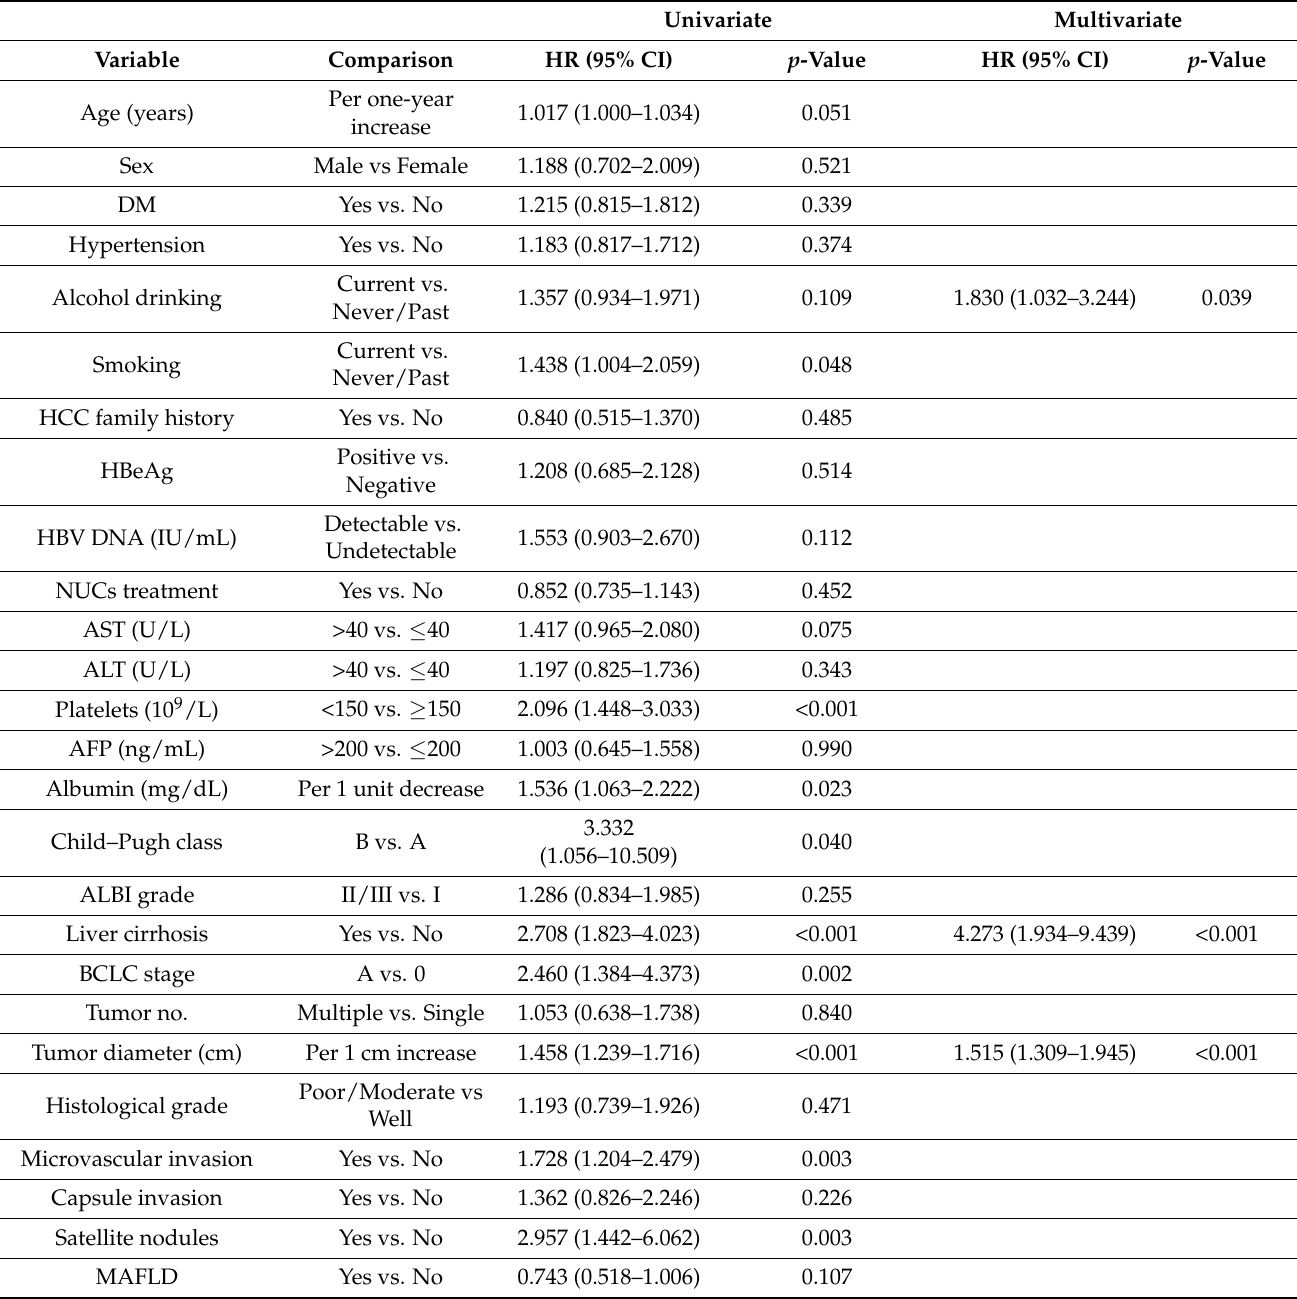
Table 3. Prognostic factors associated with mortality/liver